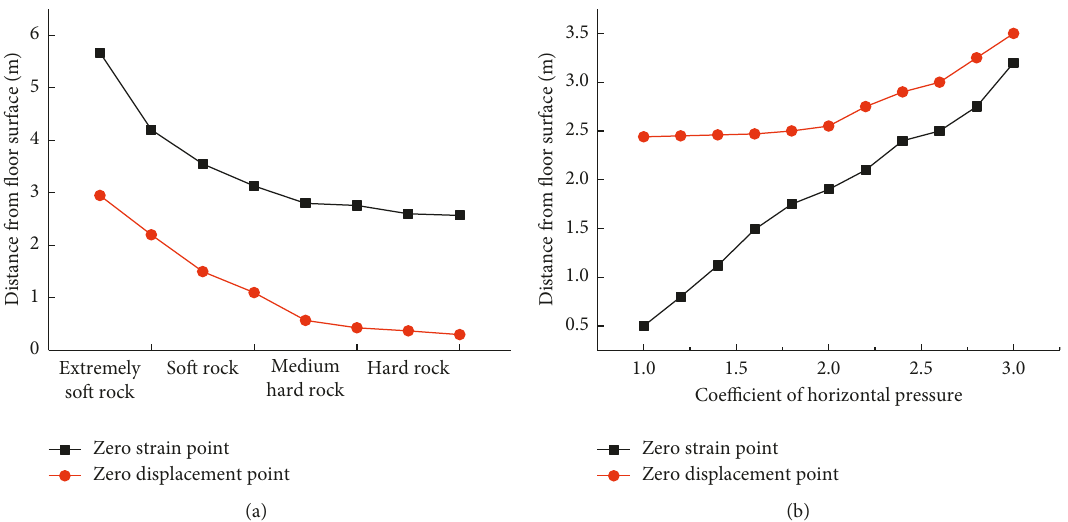
Figure 3: Factors influencing floor heave. The influence of (a) floor lithology on floor heave and (b) horizontal stress on floor